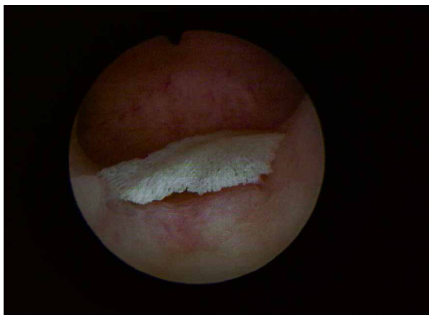
Figure 2: Hysteroscopy: intrauterine retention of fetal bone.